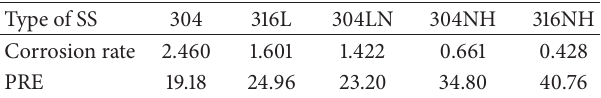
Table 4: Corrosion rate for specimens in seawater in (mpy) and pitting resistance equivalent